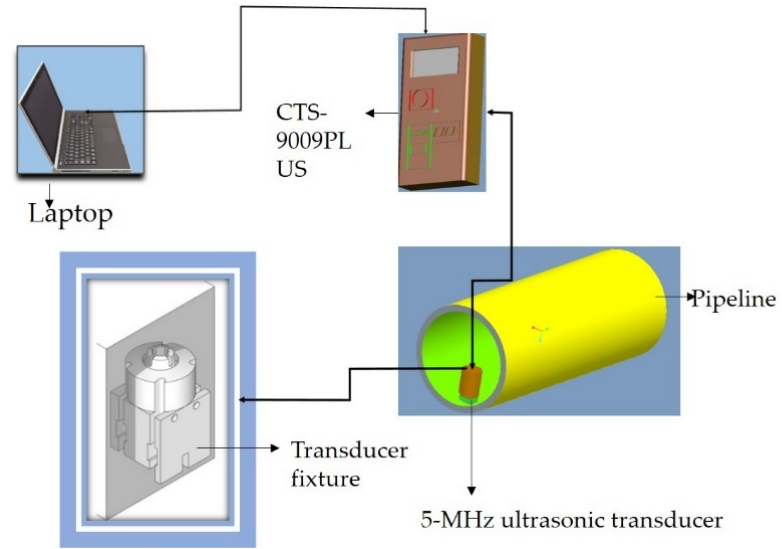
Figure 2. Ultrasound detection setup for raw data collection.